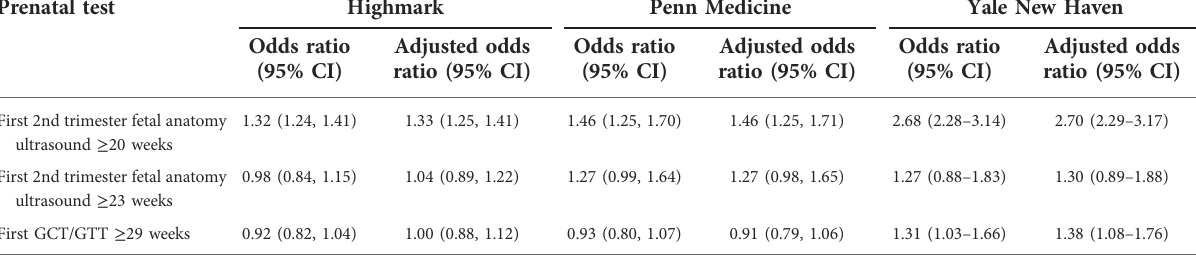
TABLE 2 Unadjusted and adjusted odds of second trimester prenatal testing timing during the COVID-19 pandemic period. Prenatal test Highmark Penn Medicine Yale New